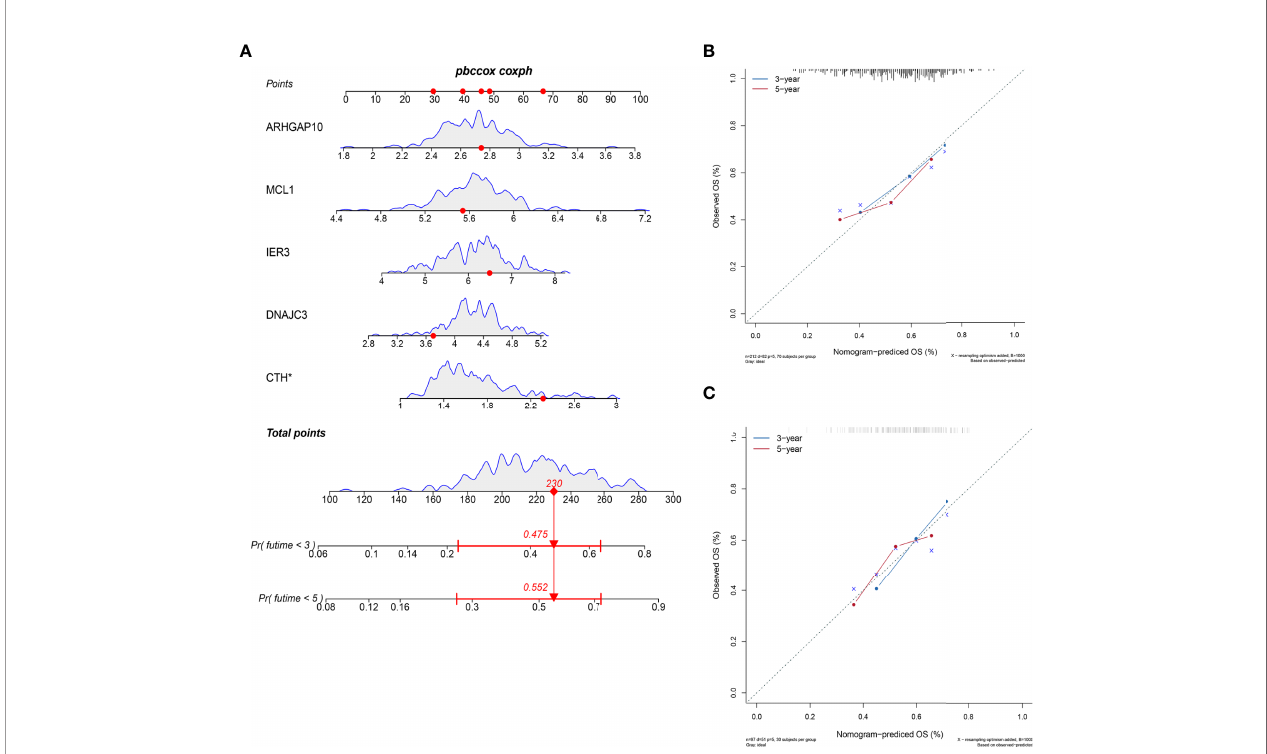
FIGURE 5 | Nomogram to predict the survival probability. (A) The six ARGs formed the prognostic nomogram that can be used to calculate 3- and 5-year survival rates. The expression values of each gene were assigned to a unique point. The total points of six genes from one patient correspond to the speci fi c survival rate of 3 or 5 years. (B) The calibration plots showed that the predicted OS of nomogram is close to the observed OS rate in the internal dataset. (C) The calibration plots showed the same accuracy of nomogram in the external